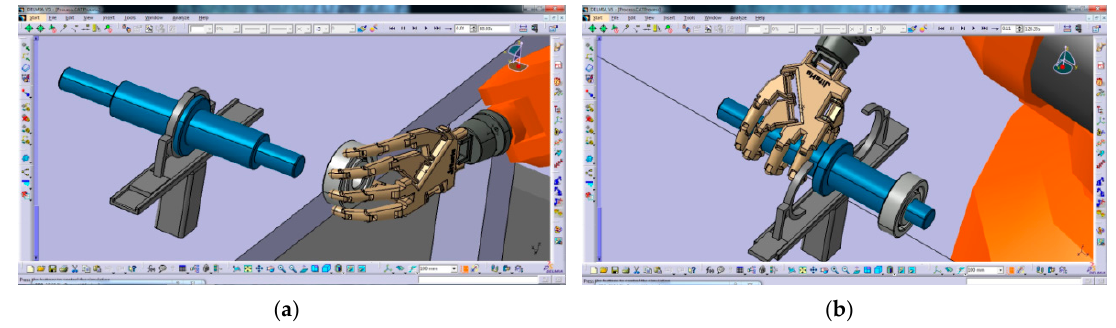
Figure 11. Simulation operations: ( a ) A bearing is mounted on a shaft; ( b ) Transfer operation.